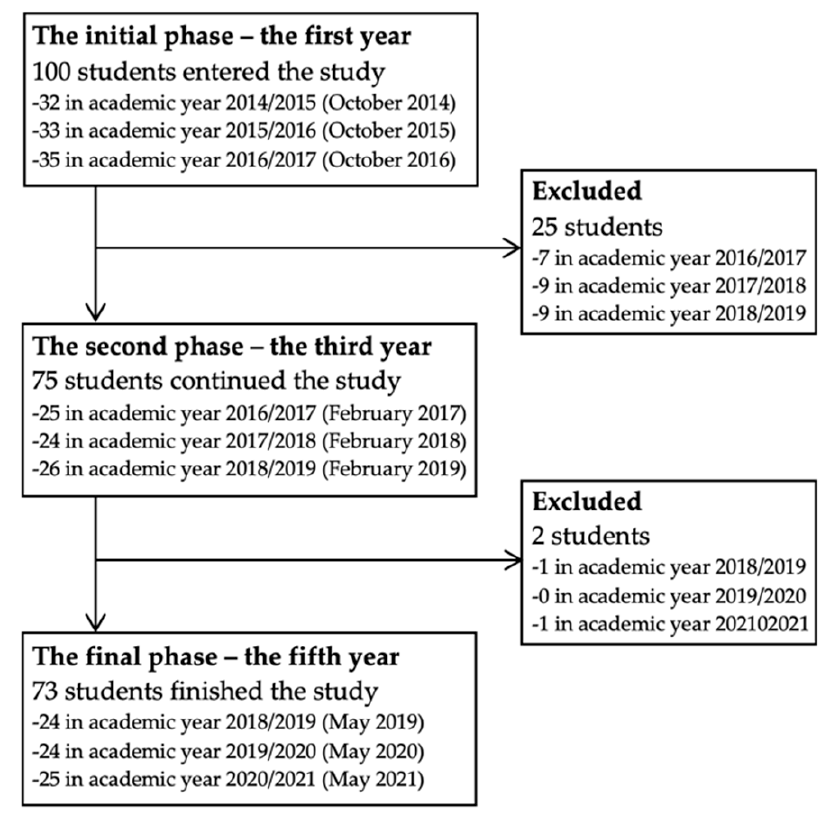
Figure 1. The flow diagram of the number of respondents participating and excluded during the running of the study.